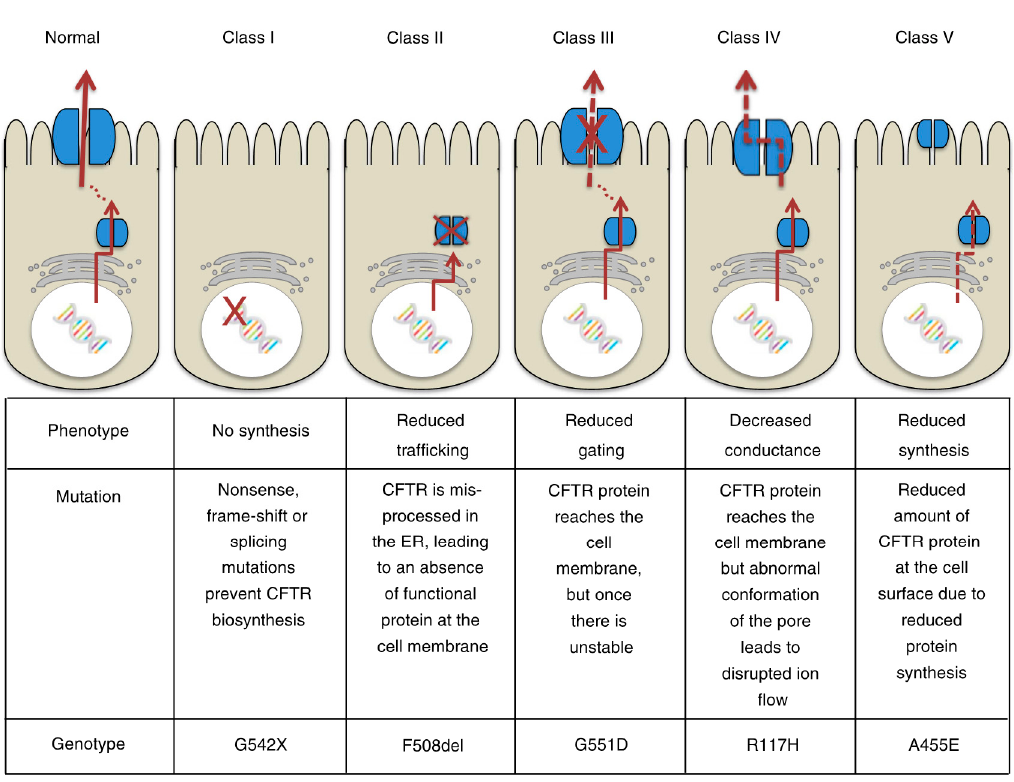
Figure 1. Classification of cystic fibrosis transmembrane conductance regulator (CFTR) mutations.